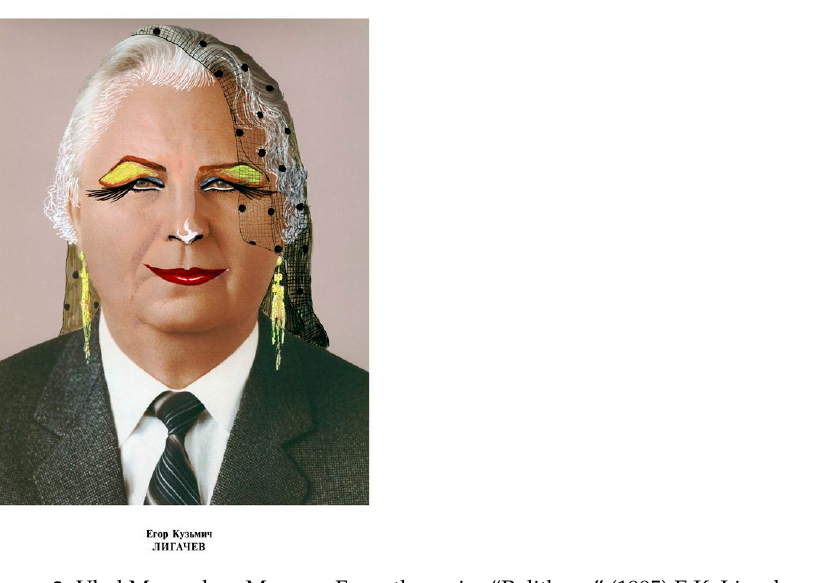
Figure 2. Vlad Mamyshev-Monroe. From the series “Politburo” (1995) E.K. Ligachev. https://vmmf.org/series/view?id=4#work-series-4-5 (accessed on 11 September 2022).